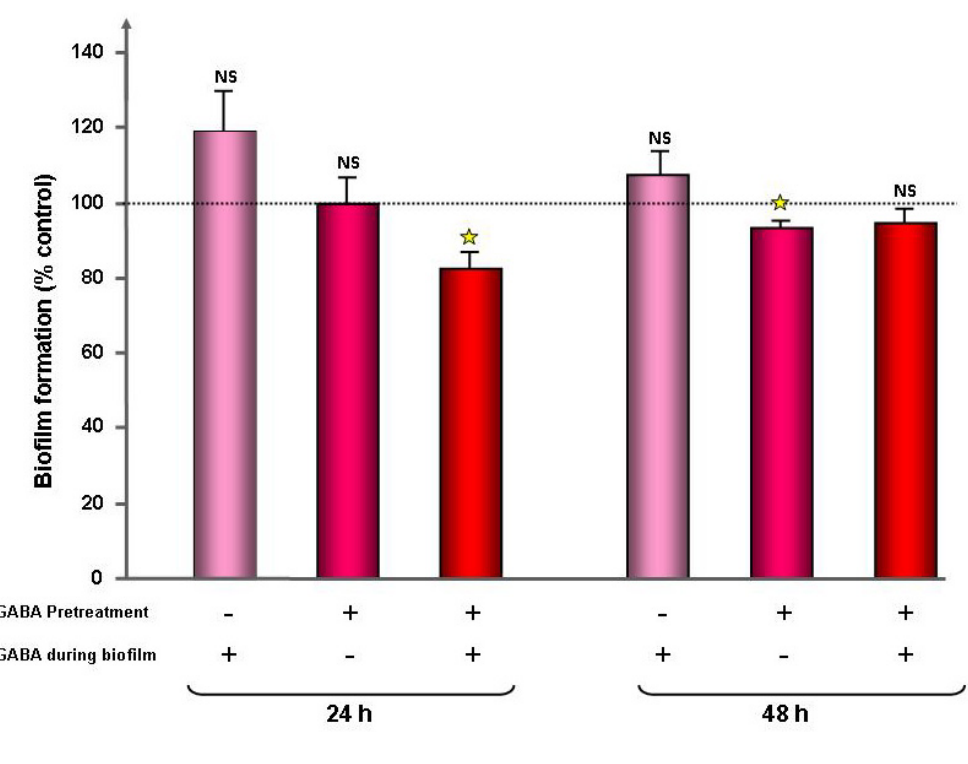
Figure 3. Effect of GABA (10 − 5 M) on the biofilm formation activity of P. fluorescens MF37 in 96-well PVC microtitration plates. The biofilm formation activity of bacteria was measured after 24 or 48 h of incubation. Bacteria were exposed to GABA only during the growth phase (pretreatment), only during the biofilm formation period (during biofilm) or continuously during growth and biofilm formation (pretreated + during biofilm). The biofilm formation activity is expressed as the percentage of the control value (dotted line). (NS: non-significant;  : p <